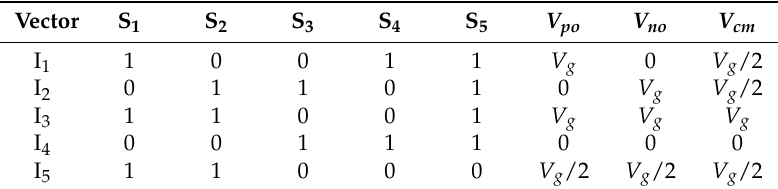
Table 2. The switching states and their voltages.